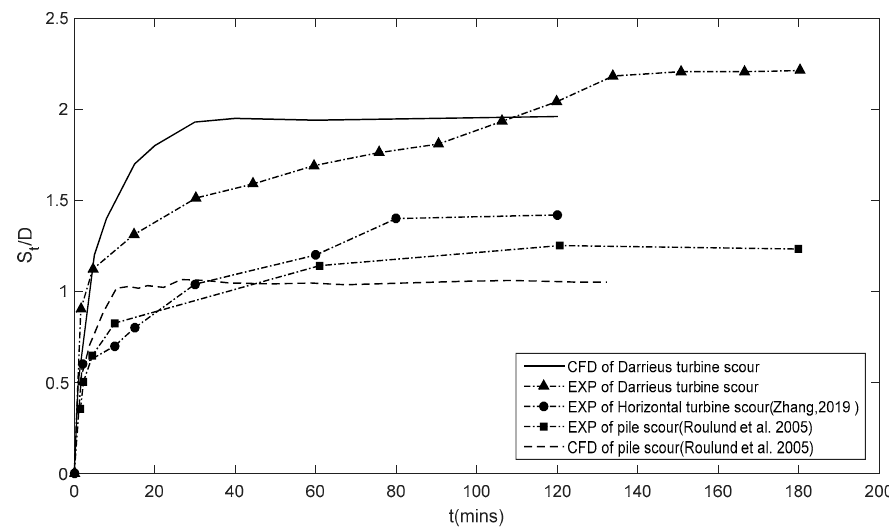
Figure 19. Temporal development of scour depth.